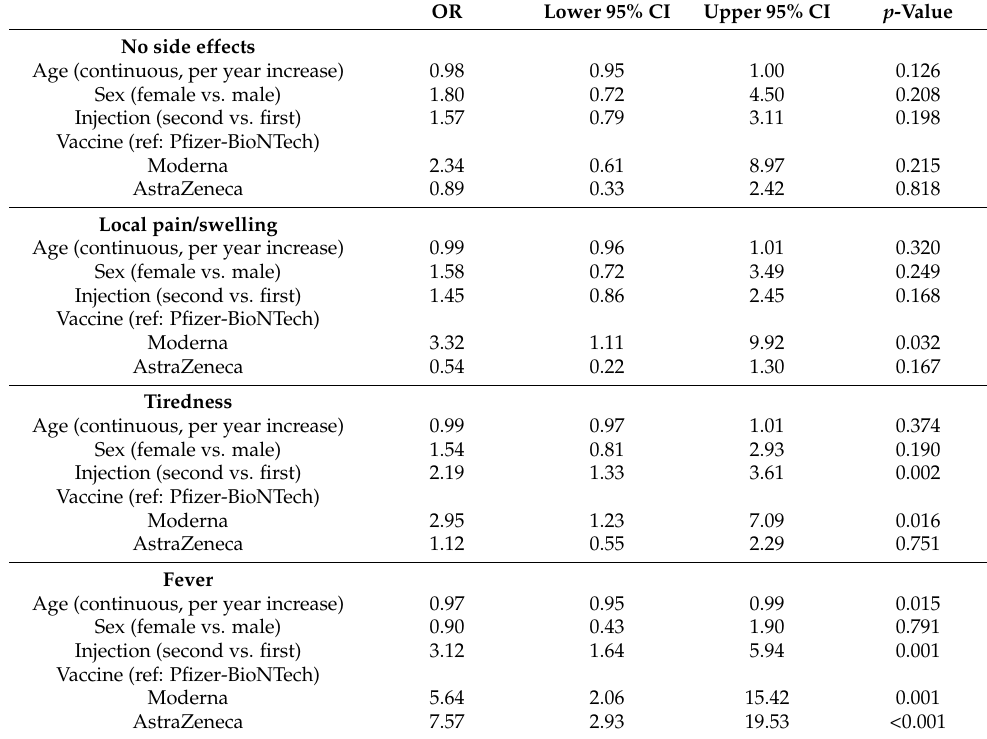
Figure 3. Self-reported side effects after first ( n = 238) and after second vaccine ( n = 214) among vaccinated participants including 95% confidence intervals (COVID-PCD study, May 2021). Other side effects included nausea, vomiting, diarrhoea, stomachache, dizziness, chills, breathlessness, cough, congestion, and swollen lymph nodes. Table 2 . Odds ratios from multilevel logistic regression analyses of reporting side effects after COVID-19 vaccination adjusted for age, sex, first or second injection, and type of vaccine ( n = 266) (COVID-PCD study, May 2021) .